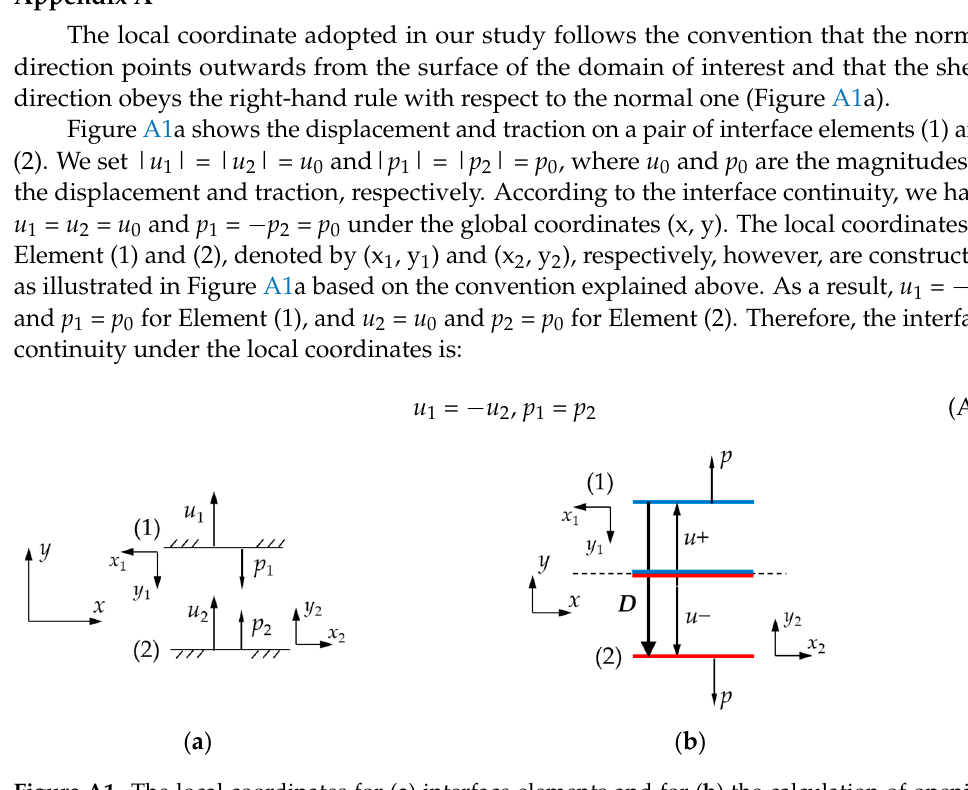
Figure A1. The local coordinates for ( a ) interface elements and for ( b ) the calculation of opening displacement [34].